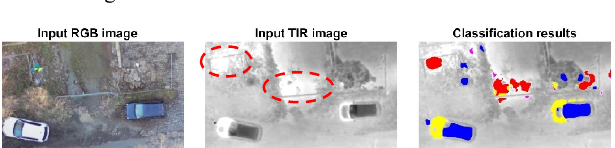
Figure 7: Phase one classification results – scene 1